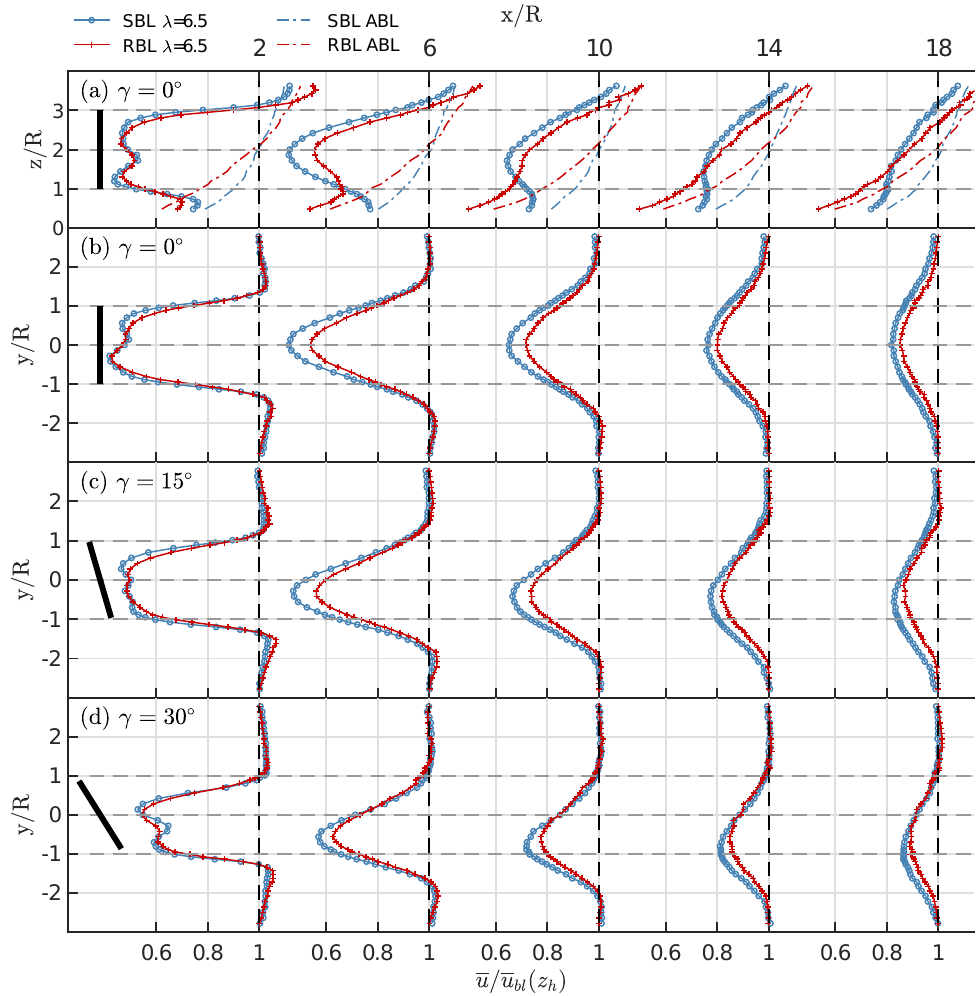
Figure 7. ( a ) Vertical and ( b – d ) horizontal profiles of the normalised streamwise velocity u / u bl ( z h ) in the wake of the model wind turbine immersed within the SBL ( blue line ) and RBL ( red line ) operating at ( a )/( b ) γ = 0 ◦ , ( c ) γ = 15 ◦ and ( d ) γ = 30 ◦ . Horizontal dashed lines indicate the rotor edges.